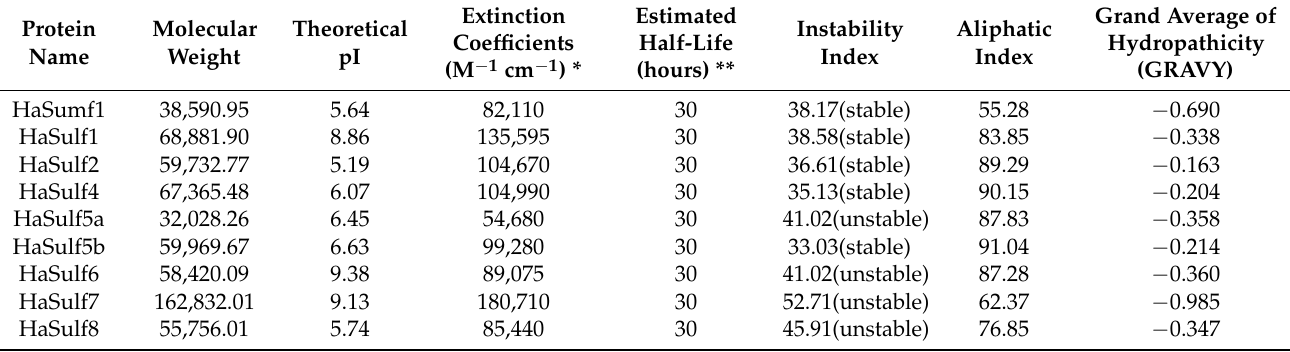
Table 3. Various physical and chemical parameters of HaSumf1 and